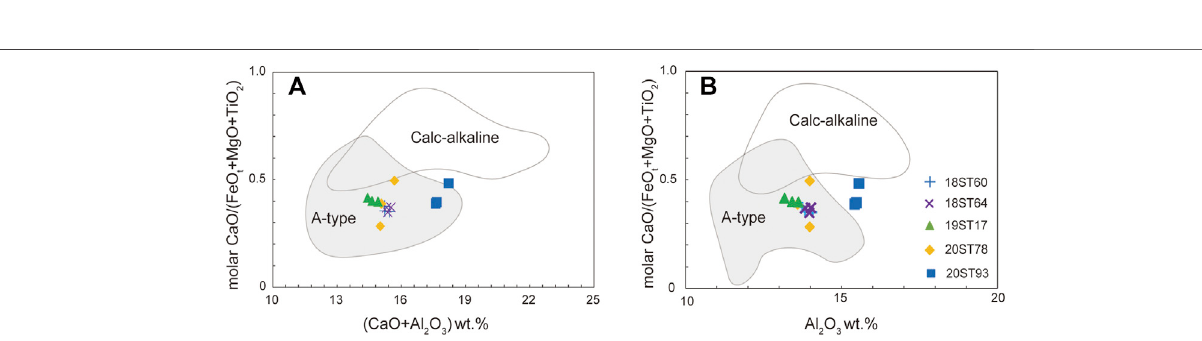
Frontiers in Earth Science |